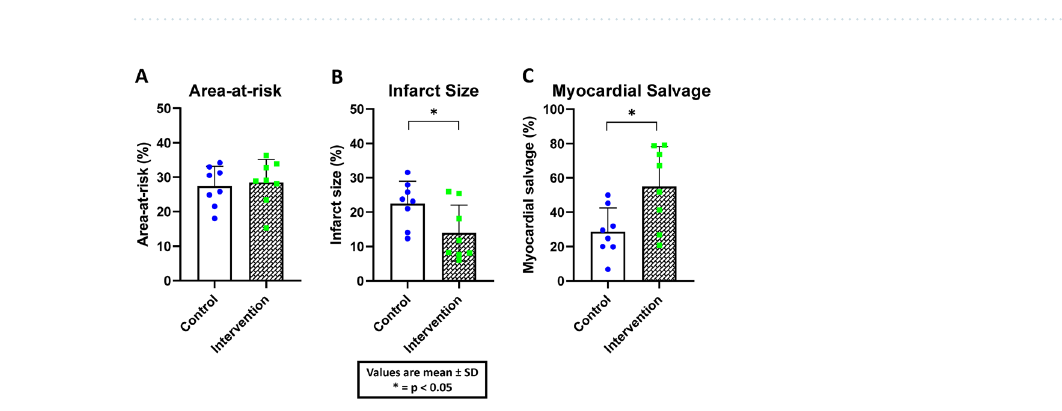
Figure 2. LV ejection fraction, mean arterial pressure, cardiac work per minute and LV end diastolic volume at the same three time points as in Fig. 1 for the control (filled blue circle) and intervention (filled green square) groups.